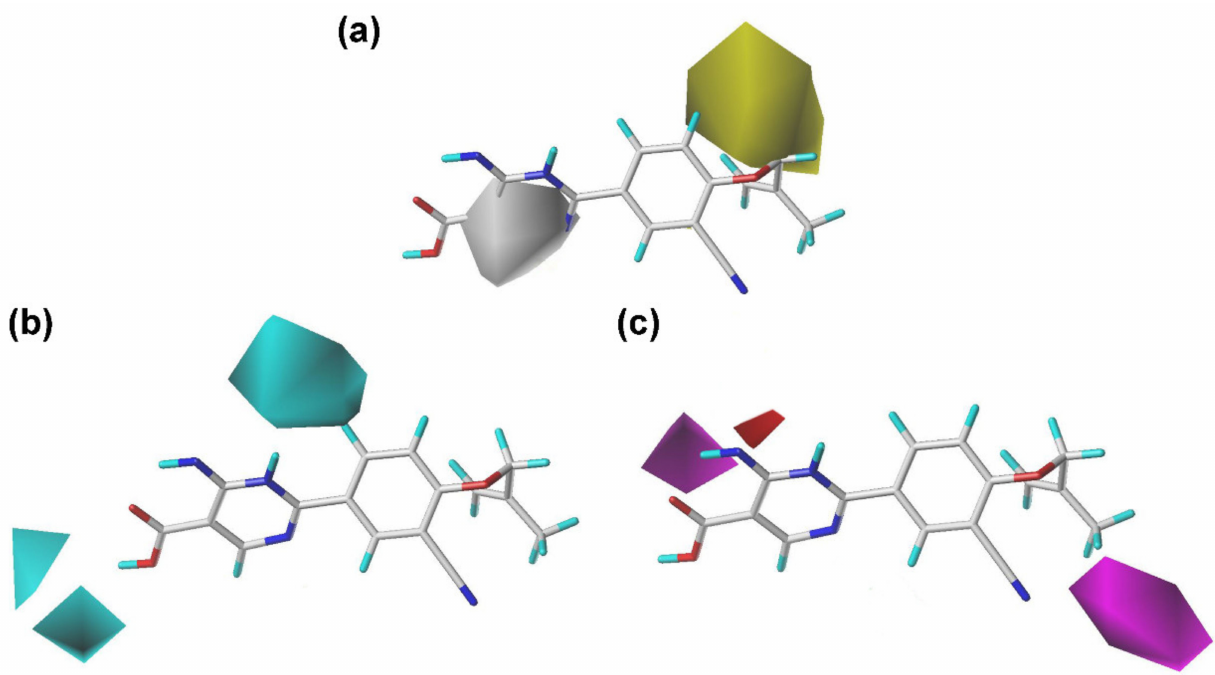
Figure 4. Contour maps of the CoMSIA-SEHDA model using compound 44 as a reference. ( a ) The hydrophobic field. ( b ) The hydrogen-bond donor field. ( c ) The hydrogen-bond acceptor